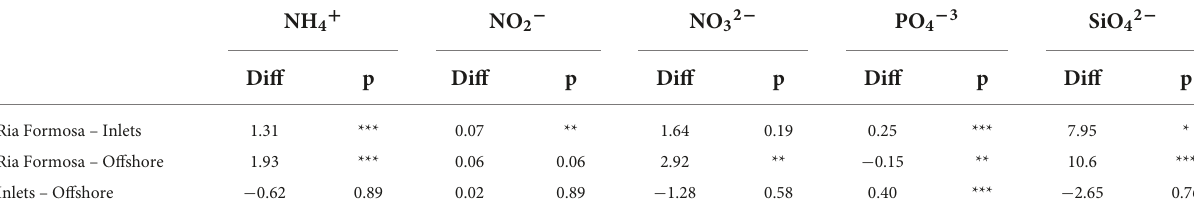
TABLE 2 Tukey’s pairwise comparisons of the nutrients’ concentrations in three different areas: the inside of the lagoon (Ria Formosa), the inlets that connect it with the sea (inlets) and the offshore waters (Offshore). NH 4 + NO 2 − NO 32 −